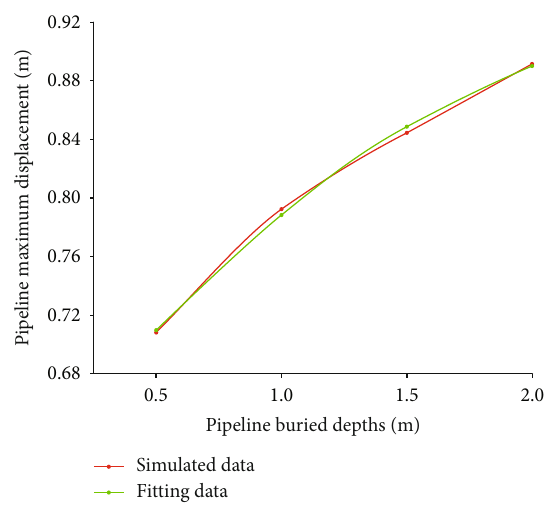
Figure 28: The pipeline maximum displacement under di ff erent pipeline buried